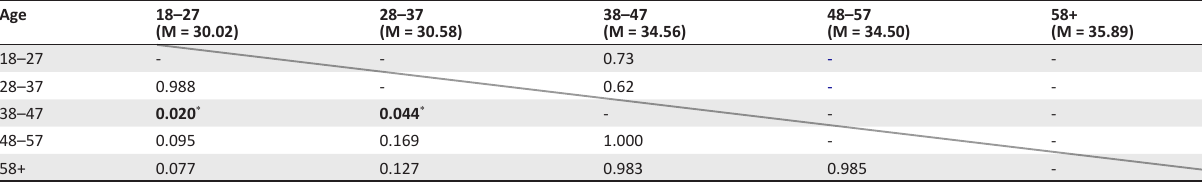
TABLE 8: Tukey tests and Cohen’s d for absorption , according to age.